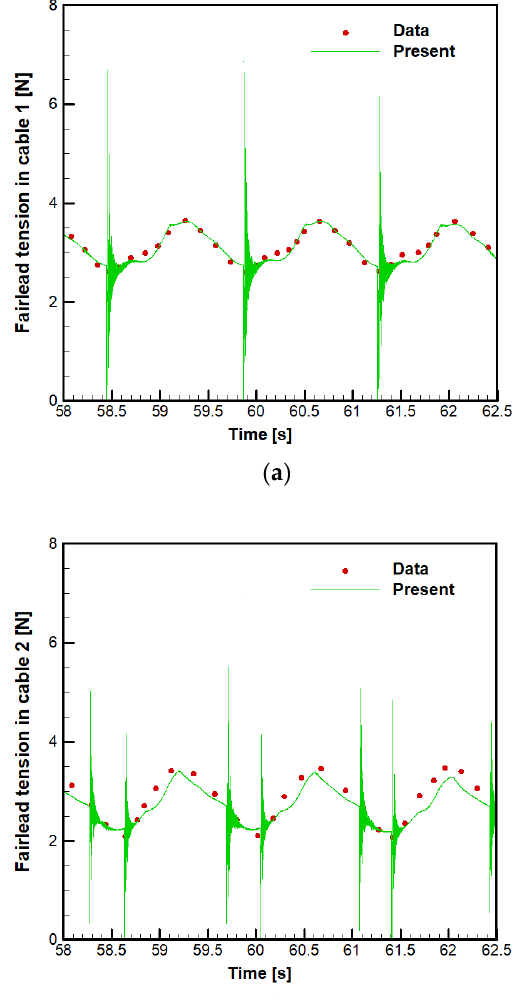
Figure 15. Fairlead tensions of moored buoy: ( a ) Fairlead tension in mooring line 1; ( b ) Fairlead tension in mooring line 2.